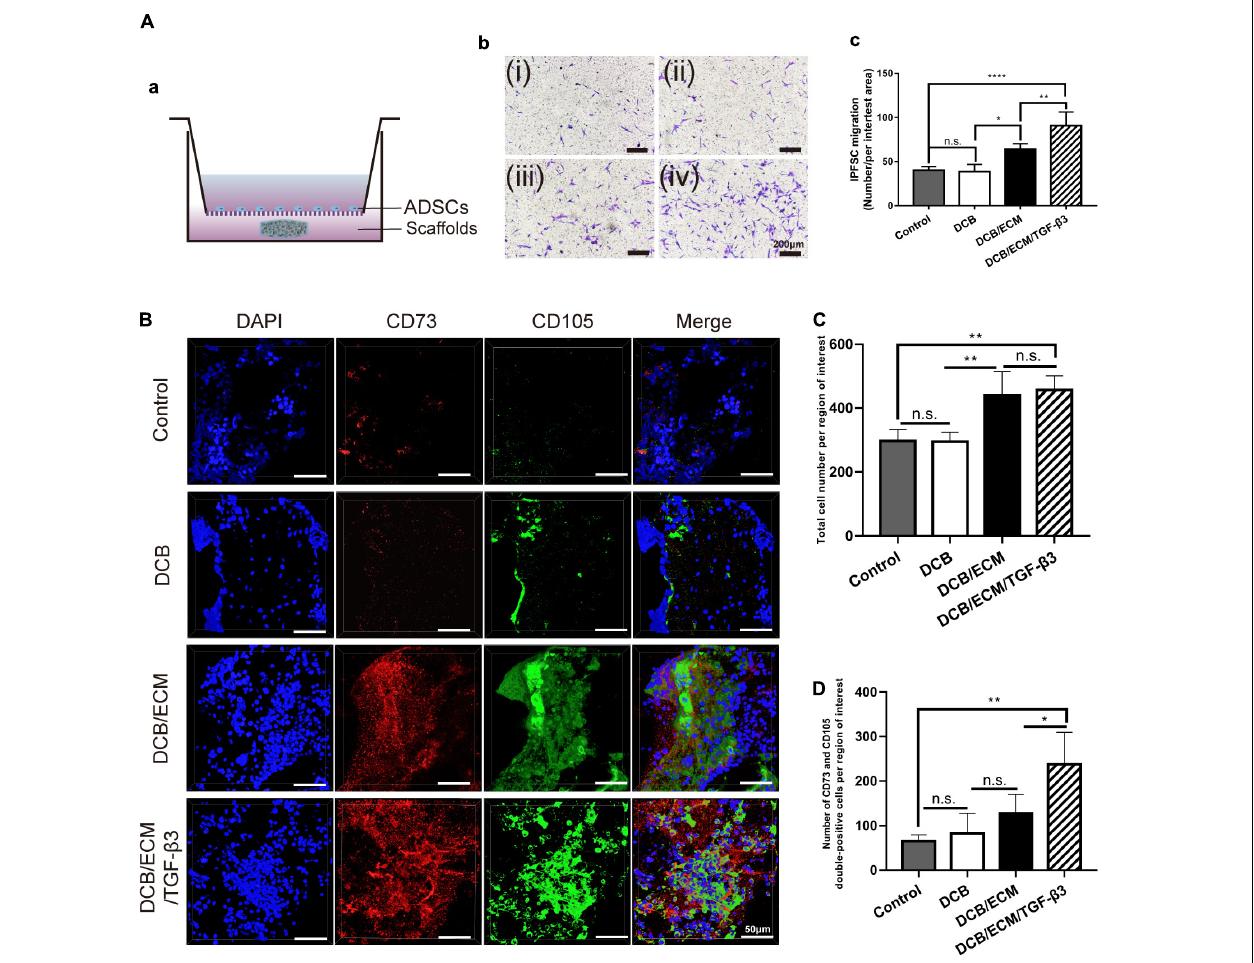
FIGURE 2 | Migratory capacity of the different scaffolds on stem cells in vitro and in vivo . (A) Effects of different scaffolds on the migration of IPFSCs. (a) Schematic illustrations of the Transwell assay. (b) The migratory cells were stained with crystal violet after culturing for 24 h (i: negative control group; ii: DCB group; iii: DCB/ECM group; iv: DCB/ECM/TGF- β 3 group). (c) Statistical analysis of the average migratory cell number per region of interest from different groups at the 24-h time point; values are presented as the means ± SDs ( n = 5). (B) Confocal images of cell migration in the different scaffold groups ( n = 5). (C) Total cell